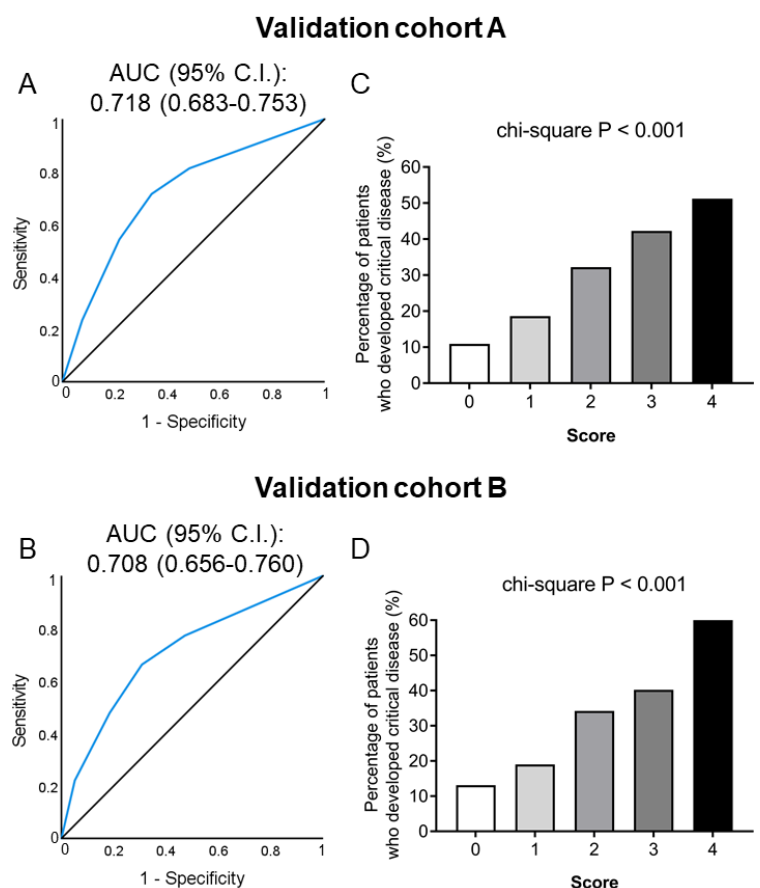
Figure 3. Predictive value of the simple score for the development of critical COVID-19 in a cohort of 1228 unvaccinated patients predominantly infected by the alpha SARS-CoV-2 variant ( A , C ) and in a cohort of 527 patients (65% unvaccinated) infected predominantly by the delta SARS-CoV-2 variant ( B , D ). Receiver operating characteristic (ROC) analysis of the simple score for discriminating patients with critical vs. non-critical COVID-19 ( A , B ). Bars represent the percentage of patients who developed critical COVID-19 ( C , D ) according to their score (0–4). Abbreviations: AUC: area under the curve, CI: confidence interval.